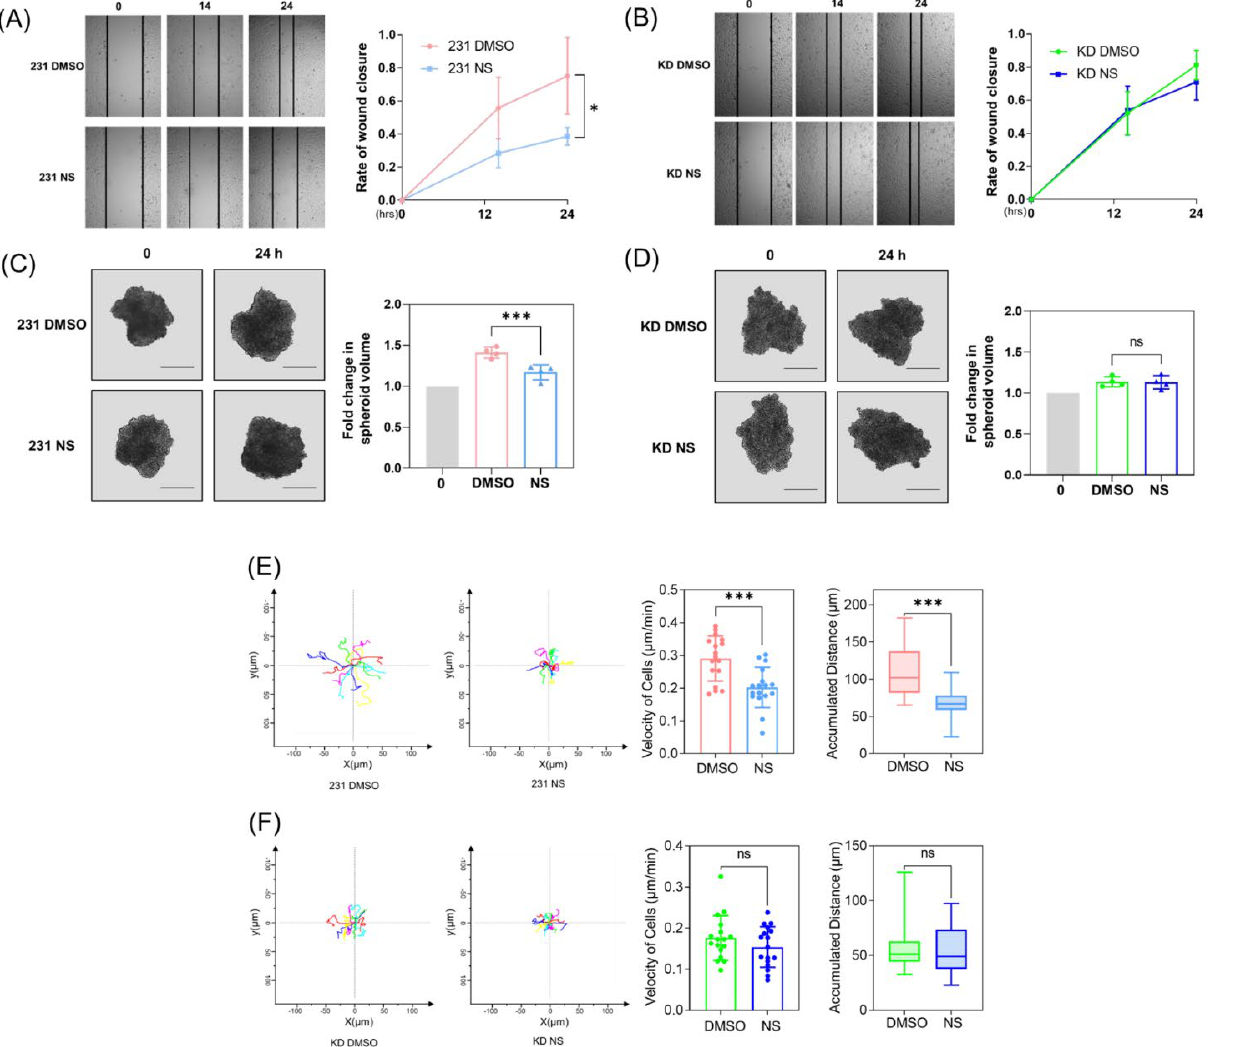
Figure 1. Kv11.1 activator NS1643 inhibits cell migration and growth in a manner dependent on Cav-1 expression. ( A ) MDA-MB-231 cells were scratch wounded and treated with DMSO or 50 μM NS1643 for 24 h. The rate of wound closure was significantly reduced by NS1643, n = 3. ( B ) Cav-1 depleted MDA-MB-231 cells (KD) were scratch wounded and treated with DMSO or 50 μM NS1643 for 24 h. The rate of wound closure was not affected by NS1643 in absence of Cav-1, n = 3. ( C ) Spheroids, generated by seeding 1000 MDA-MB-231 cells and cultured for one week, were treated with DMSO or 50 μM NS1643 for 24 h. Spheroid volume was reduced using NS1643. Scale bar = 500 μm, n = 4. ( D ) Spheroid volume was not affected by NS1643 in Cav-1 downregulated spheroids. Scale bar = 500 μm, n = 4. ns = not significant, * p < 0.05, *** p < 0.001 via ANOVA. ( E ) MDA-MB-231 cells